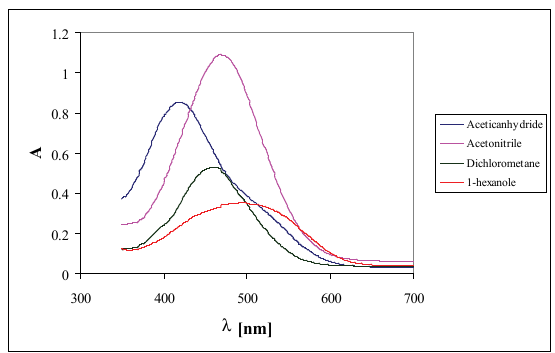
Figure 2. UV-Vis spectra of ( E )-2-(3-(4-aminostyryl)-5,5-dimethylcy- clohex-2-enylidene)malononitrile.